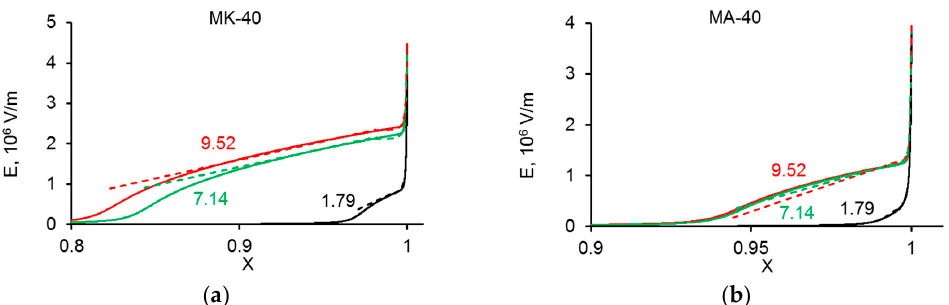
Figure 6. The electric field in the SCR of the depleted solution at the CEM ( a ) and AEM ( b ) as a function of the distance at different current densities, the values of which in mA ∙ cm − 2 are shown near the curves; x = 0 relates to the bulk solution, x = 1, to the membrane surface. The solid lines are calculated numerically, the dashed lines, using the analytical solution, Equation (A31).